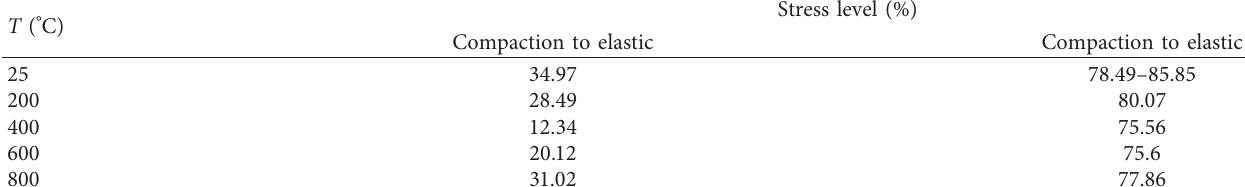
Table 5: Statistics of the incremental ratio of strain energy to axial pressure peak.